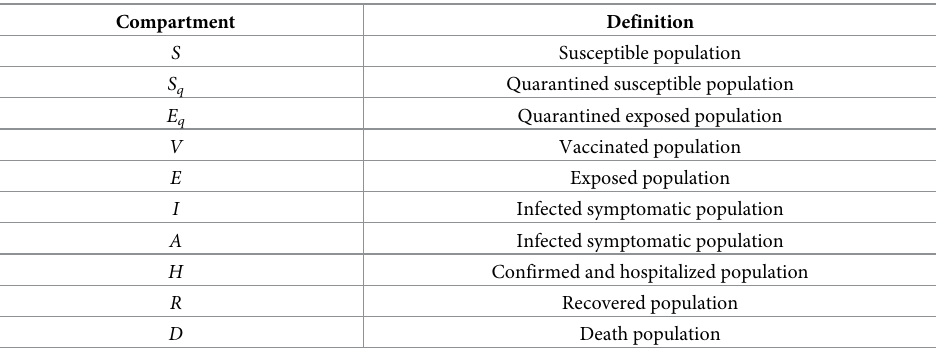
Table 1. Compartment